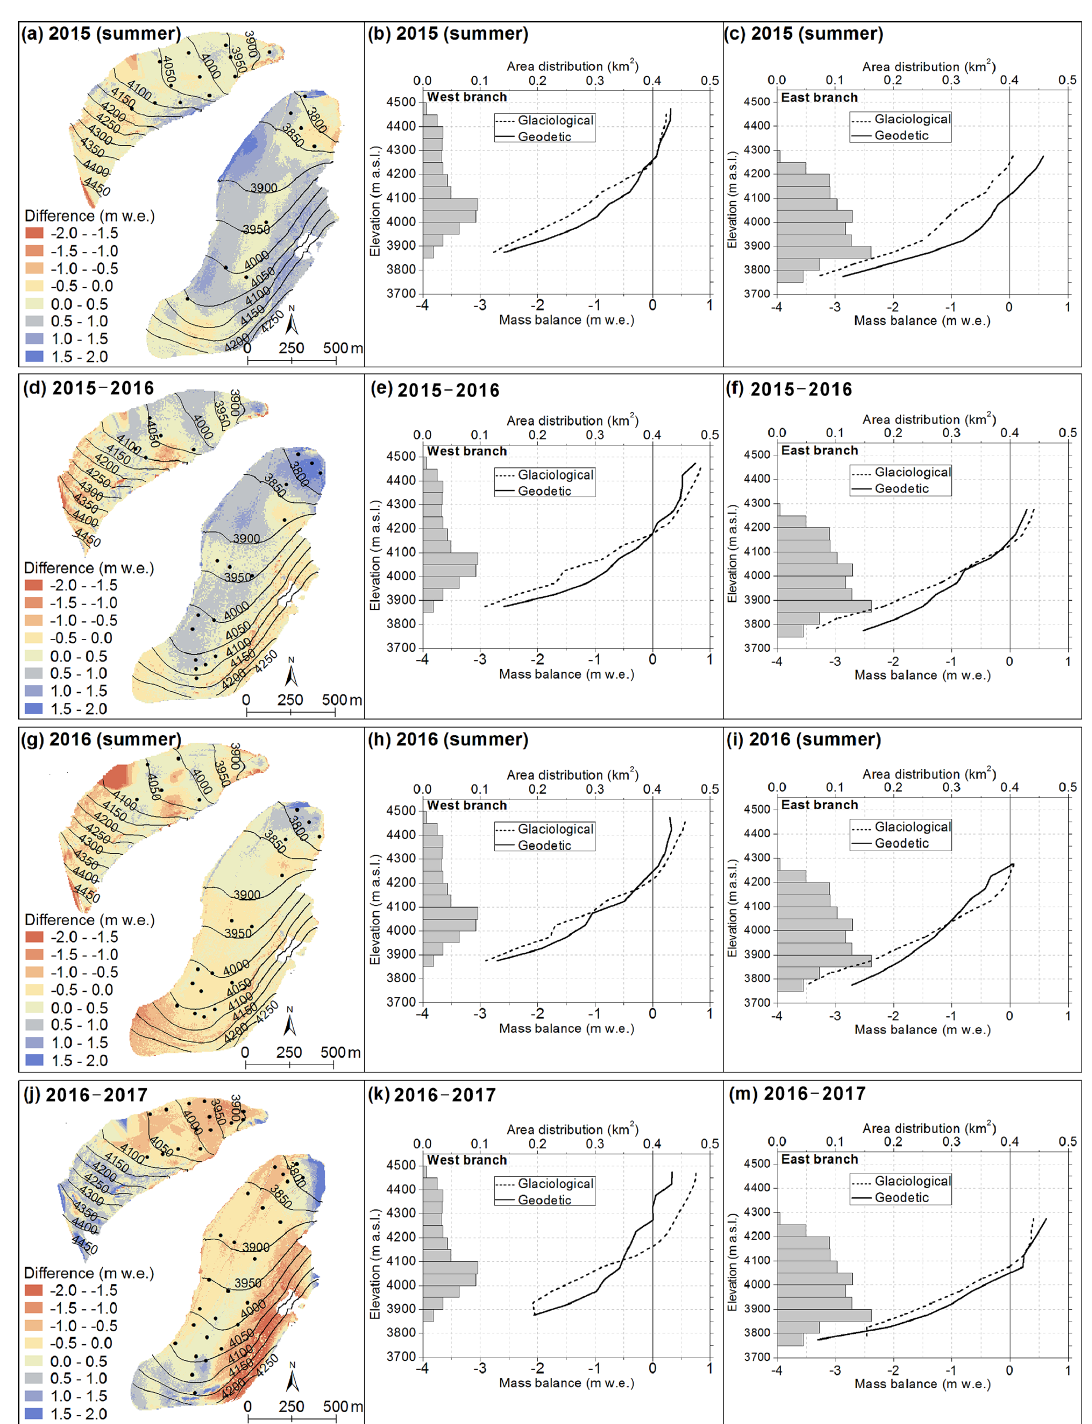
Figure 7. Spatially distributed difference derived from TLS-derived geodetic mass balance minus glaciological mass balance (a, d, g, j) . Black dots represent the location of well-measured ablation stakes, which are the same as in Fig. 5. The hypsometry (50m altitudinal ranges) and the glaciological (dotted line) and geodetic (solid line) mass-balance elevation distribution for the whole study period; both summer and annual mass balances are shown. Grey horizontal bars indicate the area-elevation distribution of Urumqi Glacier No. 1. Note that the spatial resolution of glacier-wide geodetic mass balance in summer 2015 and 2016 was downscaled to 5m in mass-balance years 2015–2016, and 2016–2017 was downscaled to 7m to coincide with glaciological glacier-wide mass balance.